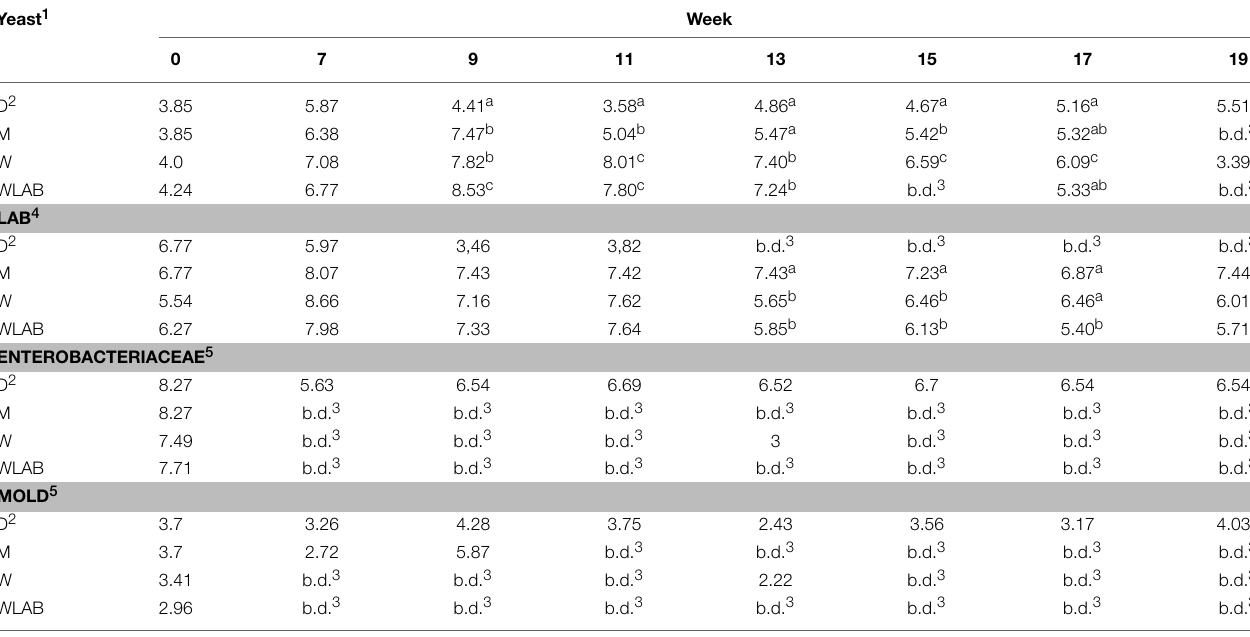
TABLE 1 | Microbial quantification of Yeast, Lactic acid bacteria (LAB), Enterobacteriaceae and Mold in dried crimped barley (D); moist crimped barley (M); moist crimped barley inoculated with Wickerhamomyces anomalus (W); moist crimped barley inoculated with Wickerhamomyces anomalus and LAB starter culture